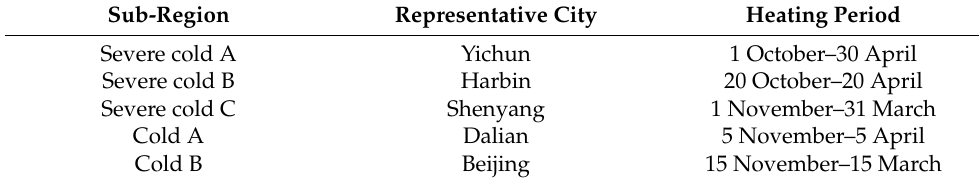
Table 7. Heating settings in five cities.